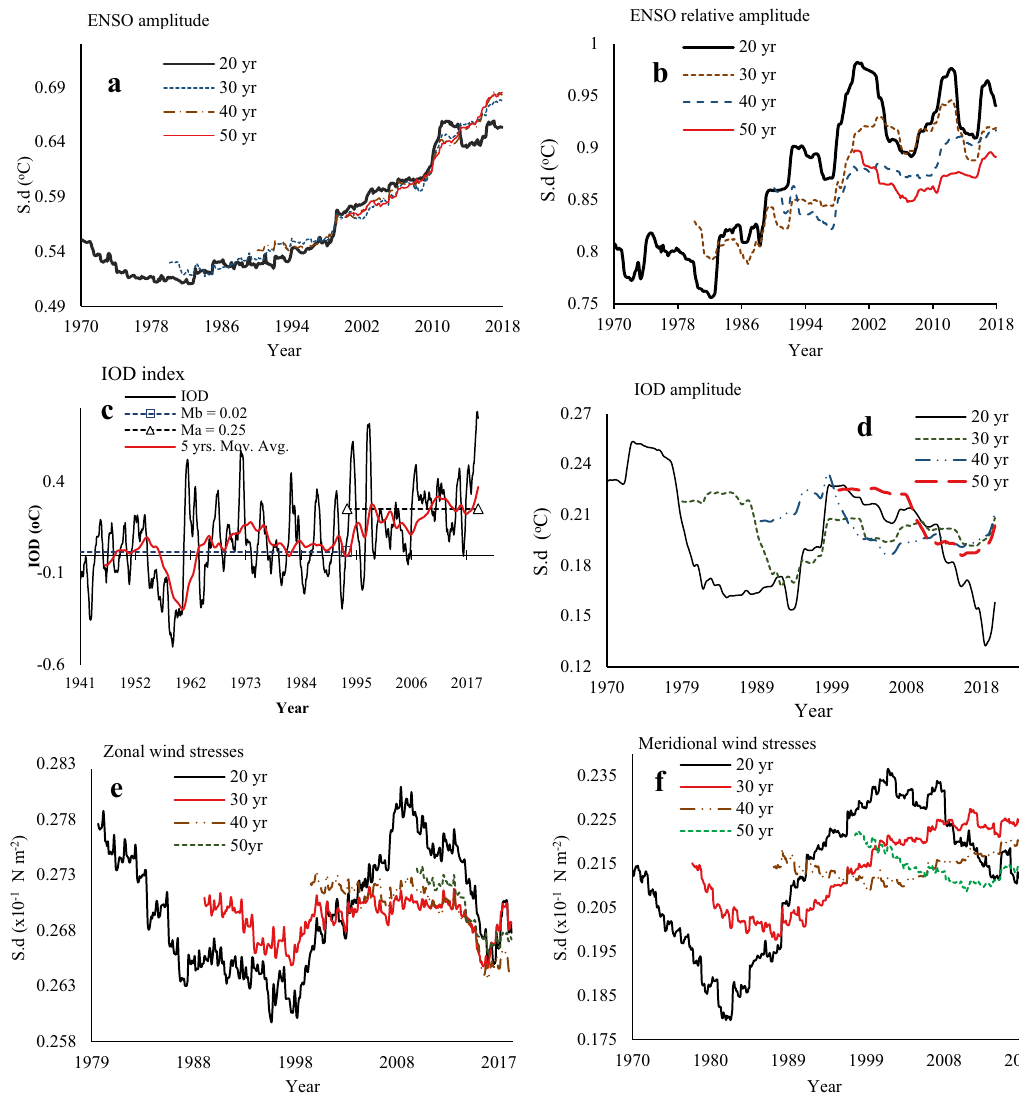
Figure 3. Observed ENSO and Indian Ocean dipole (IOD) amplitude, and zonal and meridional winds stresses over the NRB: ENSO and IOD amplitude (°C), defined as the standard deviation (s.d.) of the Niño3.4 and relative El Niño3.4 (El Niño3.4r) amplitude ( a , b ) and IOD index ( d ) over 20-, 30-, 40- and 50-year windows from 1950 to 2017, and IOD characteristics over the NRB ( c ) using the ERSST data sets. Zonal and meridional wind stresses amplitude (10 −1 N m −2 ) are defined as the s.d. of zonal and meridional winds stresses over 20-, 30-, 40- and 50-year windows from 1950 to 2017, using NCEP/NCAR data sets from 1950–2017 ( e , f ). An increasing meridional wind amplitude ( e ) associated with a prominent anticyclonic circulation in southern NRB have contributed to the observed increasing intensity of recent El Niño events ( a , b